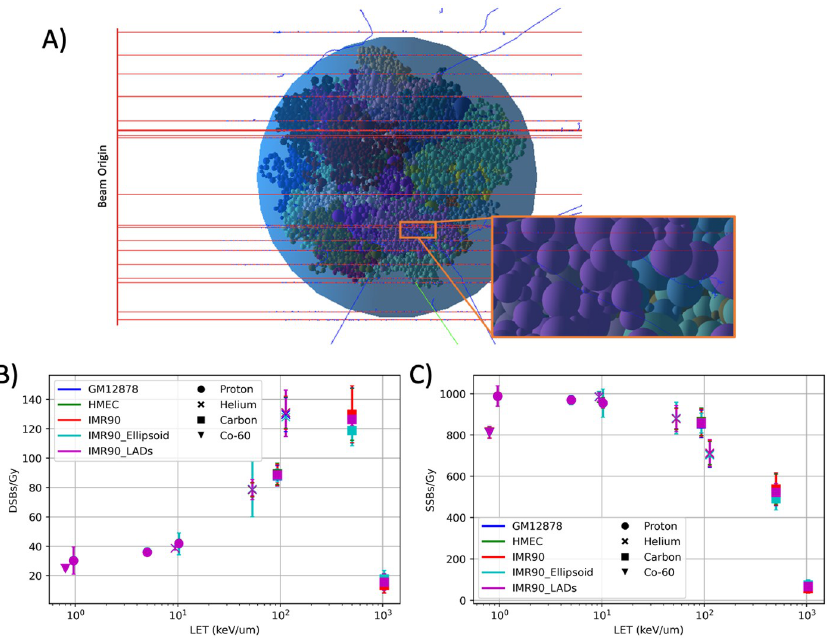
Fig 4. Geant4 DNA damage simulation results. A) visualisation of Hi-C geometry within Geant4-DNA being irradiated by a primary proton beam (red), generated secondary electrons (blue) and emergent gamma-rays from excitation (green). B) damage yields DSBs and C) damage yields SSBs per Gy of dose from the irradiation of Co-60 photons, protons, helium- and carbon-ions. Error bars are the standard deviation between the 200 geometries, where each geometry has 50 independent